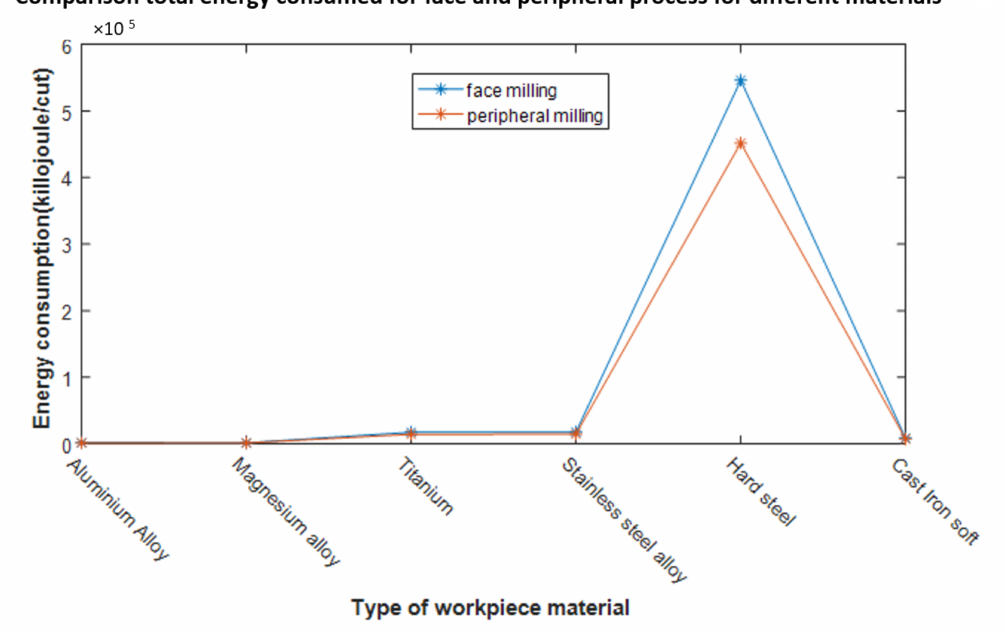
Figure 10. Comparison of total energy consumed for face and peripheral processes for different